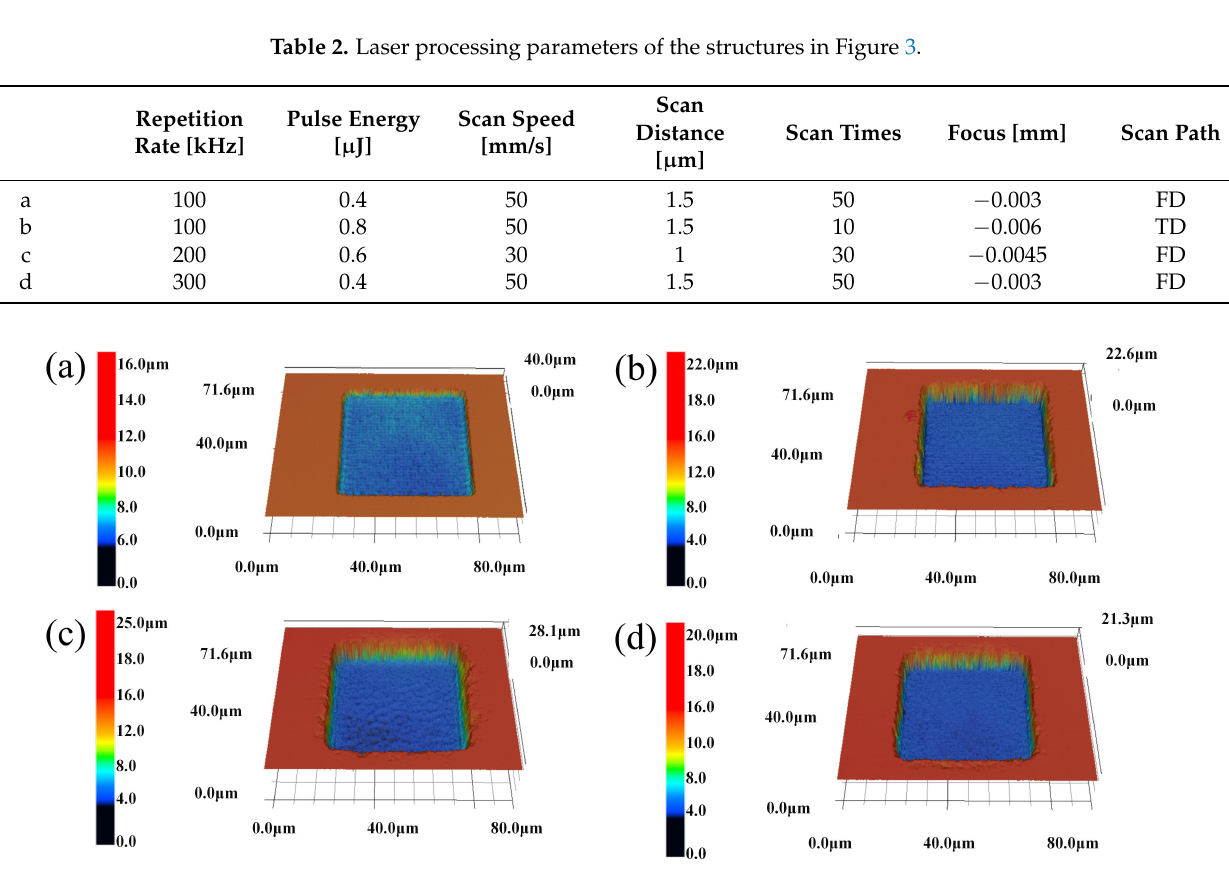
Figure 3. Three-dimensional morphology of some sample structures. The laser processing parameters of ( a – d ) are shown in Table